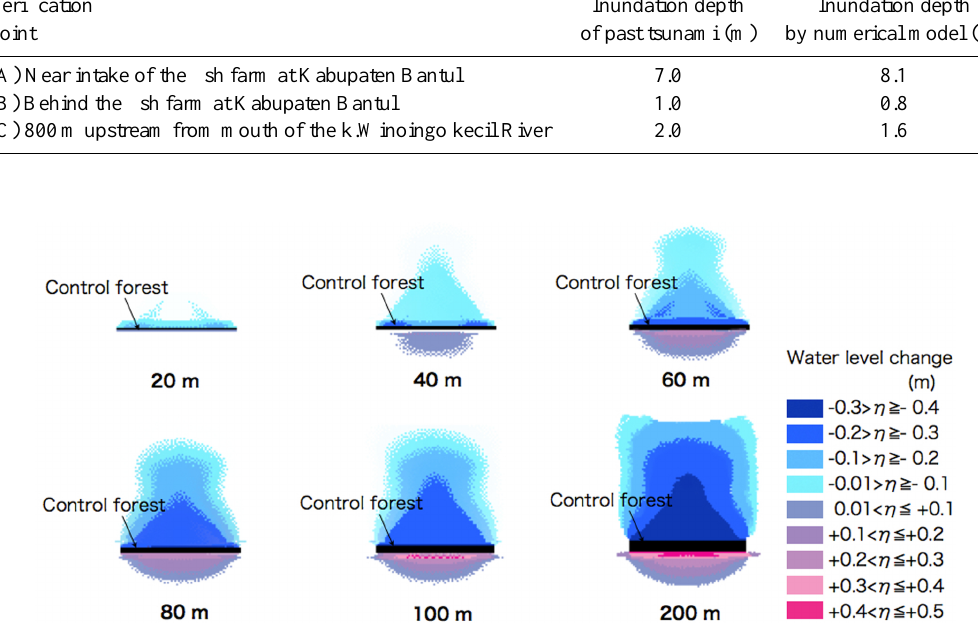
Fig. 8. The differences in the inundation depth around the forest (with-without forest). reduction in the inundation flux, depth, run-up distance, and area, respectively. The transmission of the inundation flux was clearly lower than the inundation depth (Fig.